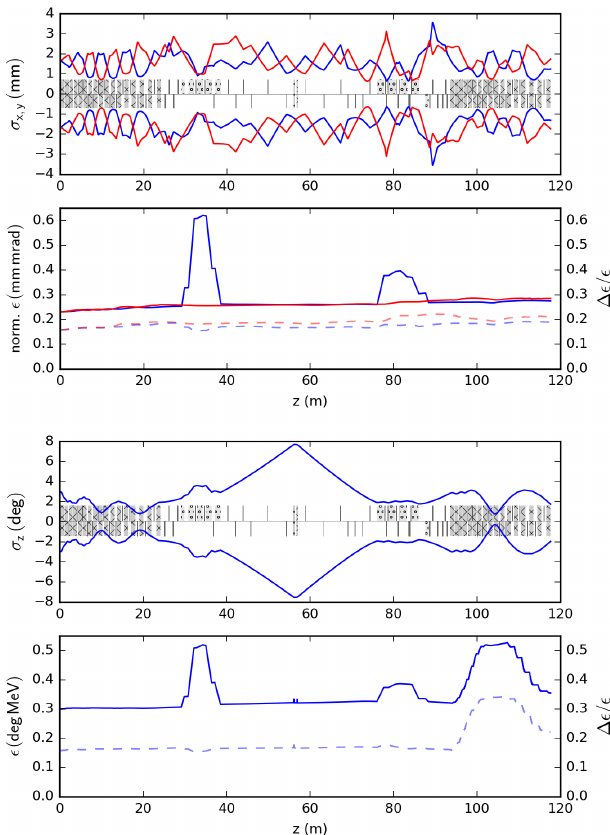
FIG. 18. rms beam statistics from the first-pass LINAC entrance to the second-pass LINAC exit with 20 mA bunch current and a Gaussian initial distribution.